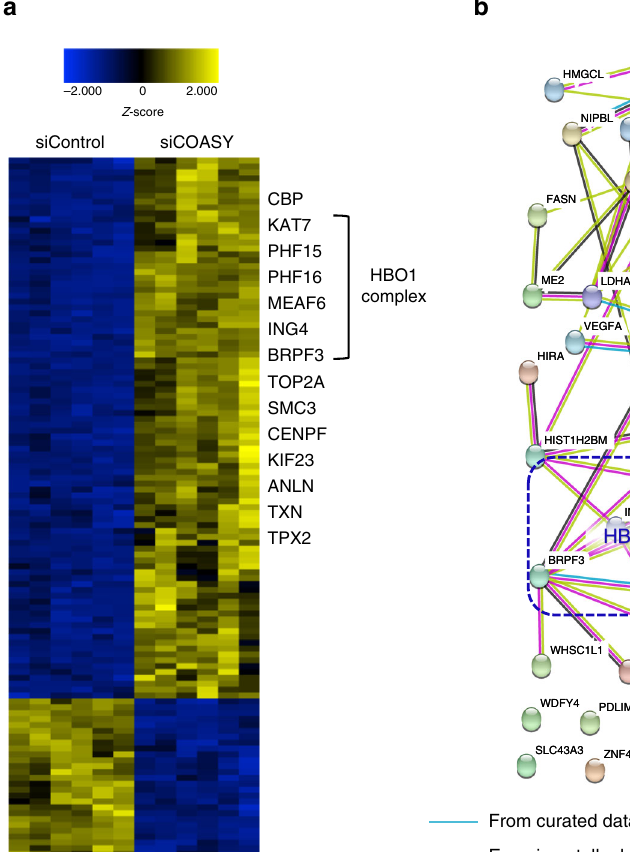
Fig. 1 COASY knockdown induced multinucleation and prolonged mitosis. a , b COASY knockdown by siRNA in MDA-MB231 triggered cobble-stone morphological change ( a ) and multinucleation ( b ). MDA-MB-231 cells transfected with control or COASY siRNA for 72 h were stained with DAPI (nuclei) and Alexa Fluor 488 phalloidin (F-actin). Scale bars, 50 mm ( a ), 20 mm ( b ). c The percentage of multi-nucleated A549 cells after transfection with control or two independent COASY siRNAs for 72 h. For each sample, more than 150 cells were examined by immuno fl uorescence microscopy. d Live cell time- lapse imaging showed that COASY knockdown extended mitosis and induced cytokinesis failure. A549 cells expressing histone 2B (H2B)-mCherry (nucleus marker) were transfected with control or COASY siRNA for 24 h before live cell imaging. Scale bars, 10 mm. e COASY knockdown increased the time in mitosis as determined by the time of nuclear envelope breakdown (NEBD) to anaphase onset (in min). For each sample, more than 35 cells were examined by live cell imaging. f COASY knockdown increased percentage of cytokinesis failure during mitosis. For each sample, more than 35 cells were examined by live cell imaging. g Western blots show that COASY knockdown extend the time of mitosis by using cyclin B1 expression as a mitotic marker. A549 cells were synchronized by thymidine-nocodazole block and released in fresh media. The samples were then harvested every 20 min and analyzed by western blots. Bars show standard error of the mean. ** p < 0.01, *** p < 0.001, two-tailed Student ’ s t -test, n = 3 independent